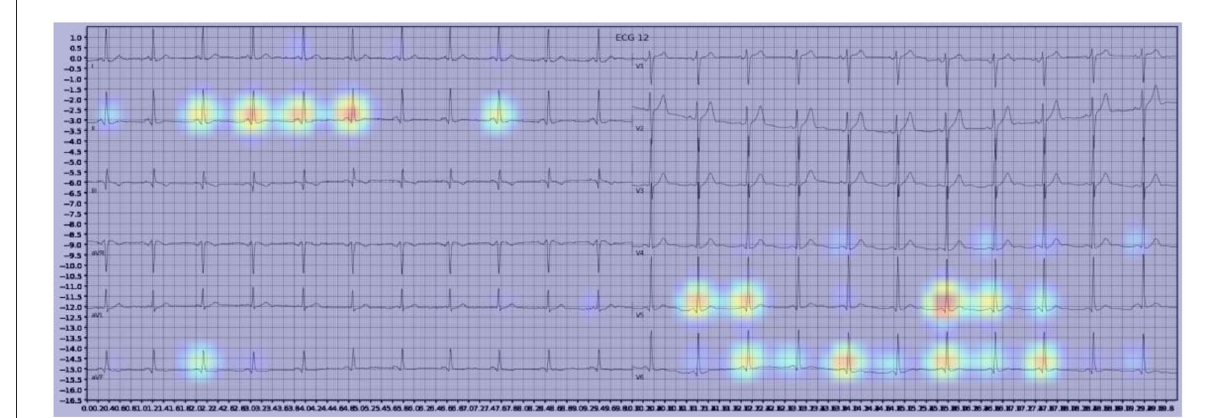
FIGURE3 Example of an activation heatmap for an ECG showing WPW.